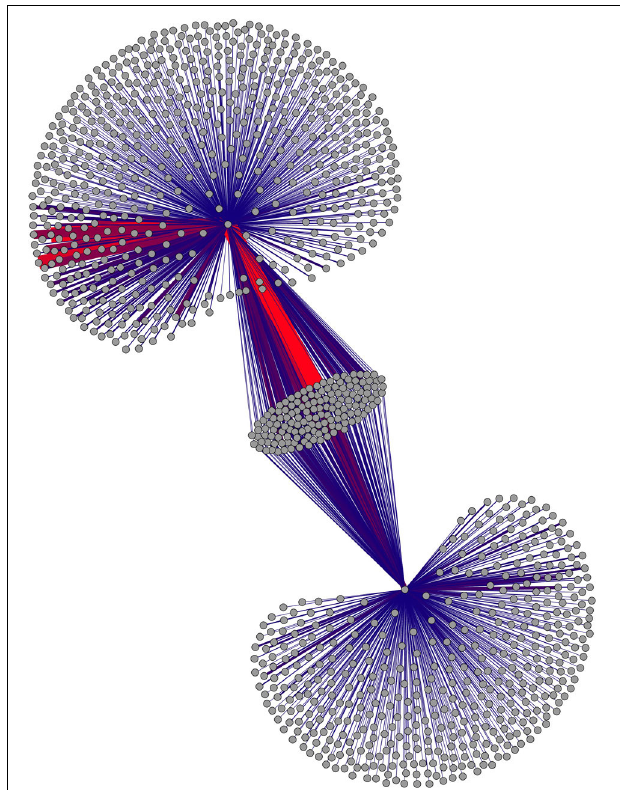
FIGURE 2 | First-order associates of sushi and octopus. Connectivity between associates is not displayed. This subgraph is small enough to display weight information as well; weight of connections is depicted by color (red = large weights) as well as thickness. Figure produced using Force Atlas and Yifan-Hu layout algorithms in Gephi (Bastian et al.,